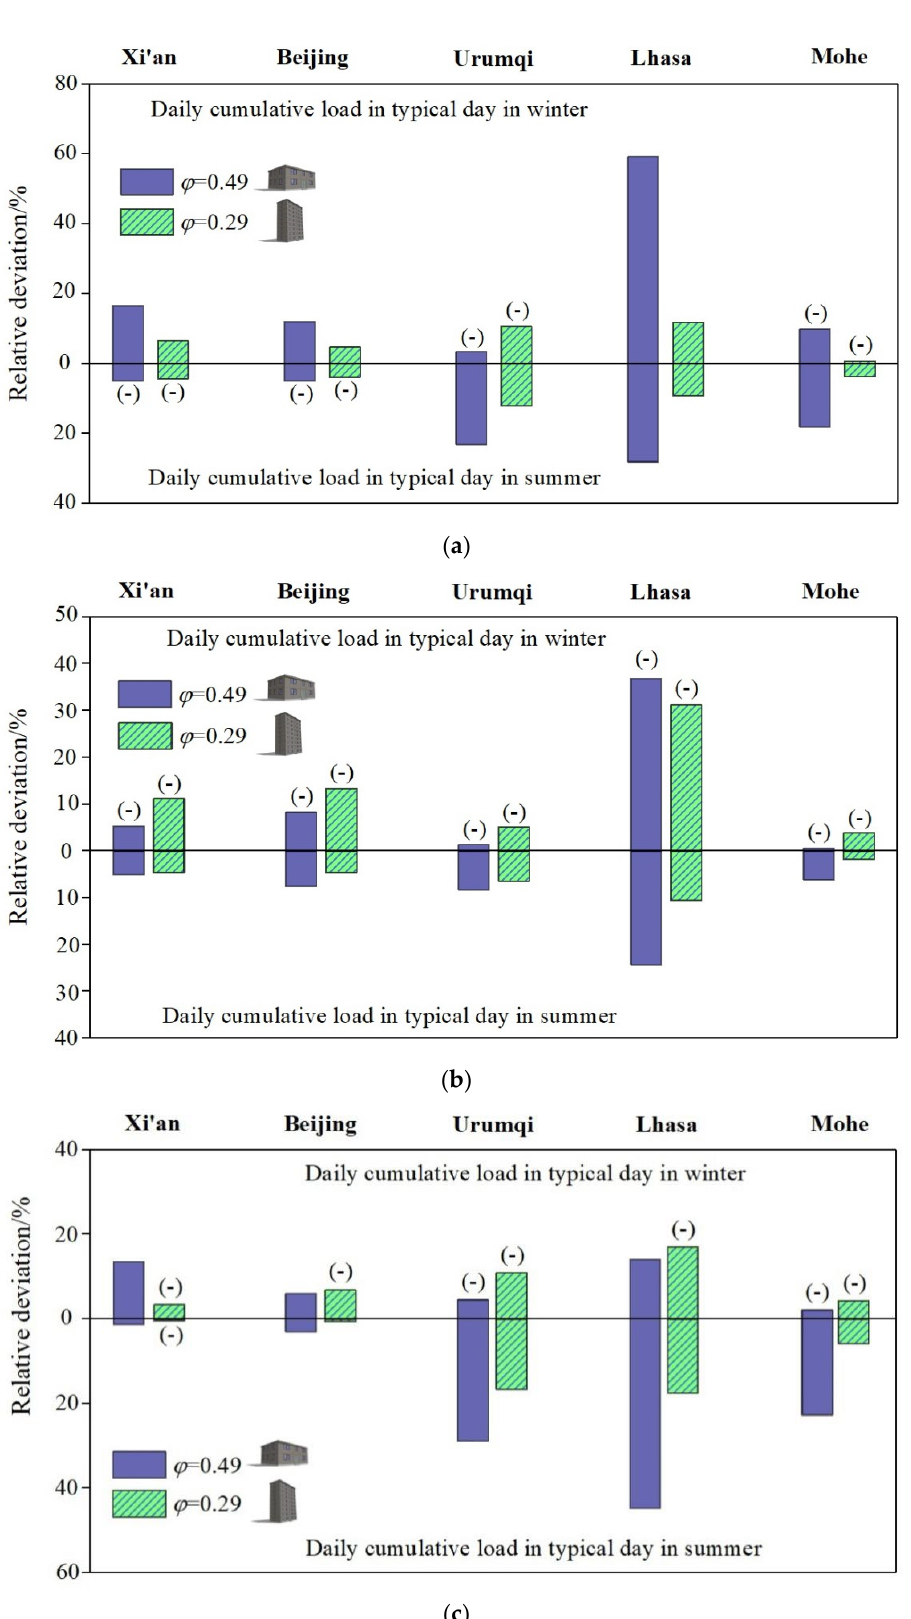
Figure 9. Comparisons of daily cumulative loads with different SHTCs on a typical day: ( a ) Indoor side with the TARP model; ( b ) Outdoor side with the TARP model; ( c ) Both sides with the TARP model.